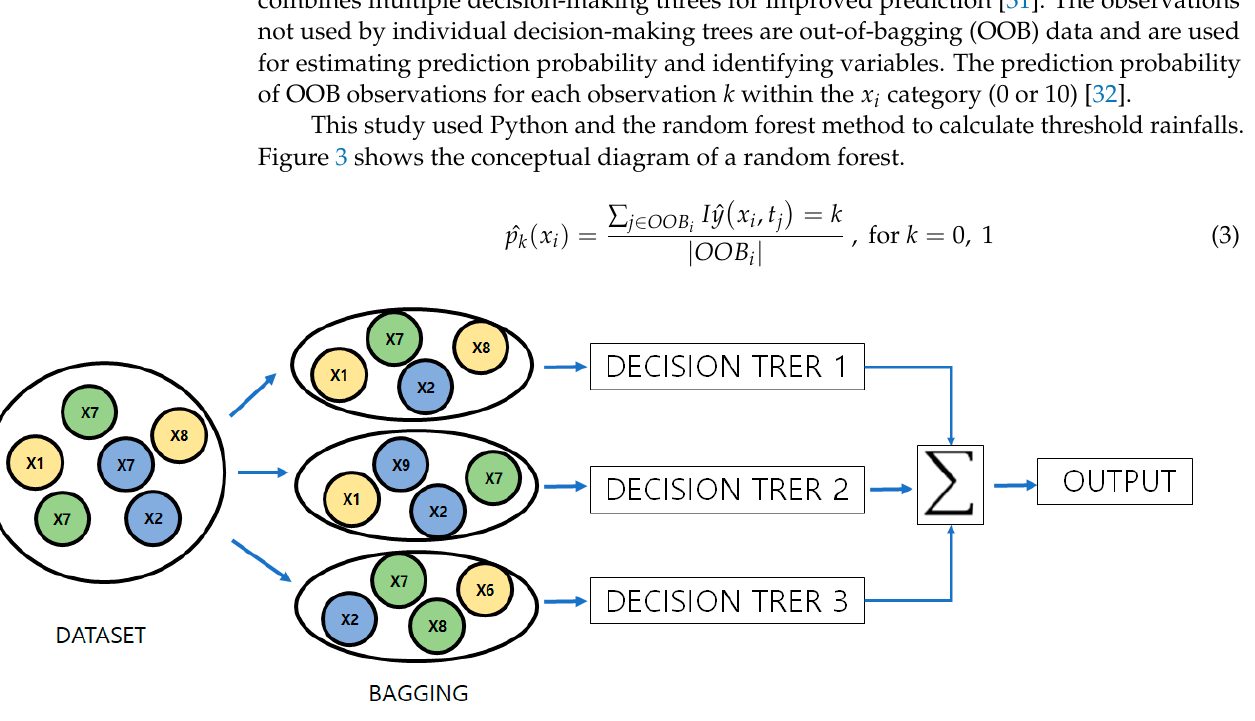
Figure 3. Concept of Random